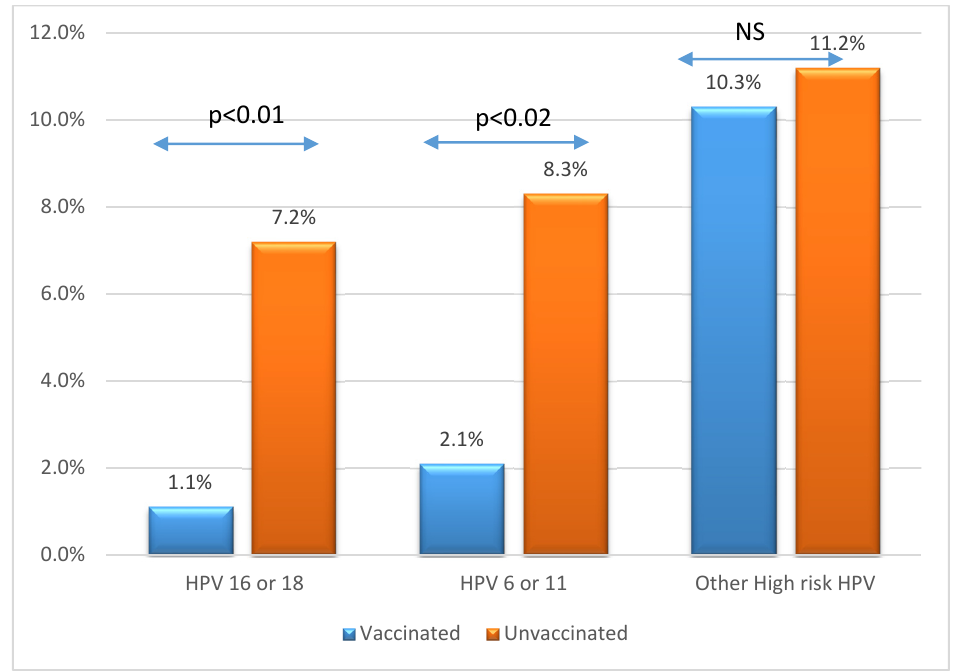
Figure 1. Human papillomavirus (HPV) genotype prevalence and distributions. In the case of multiple genotypes, each genotype was counted independently.